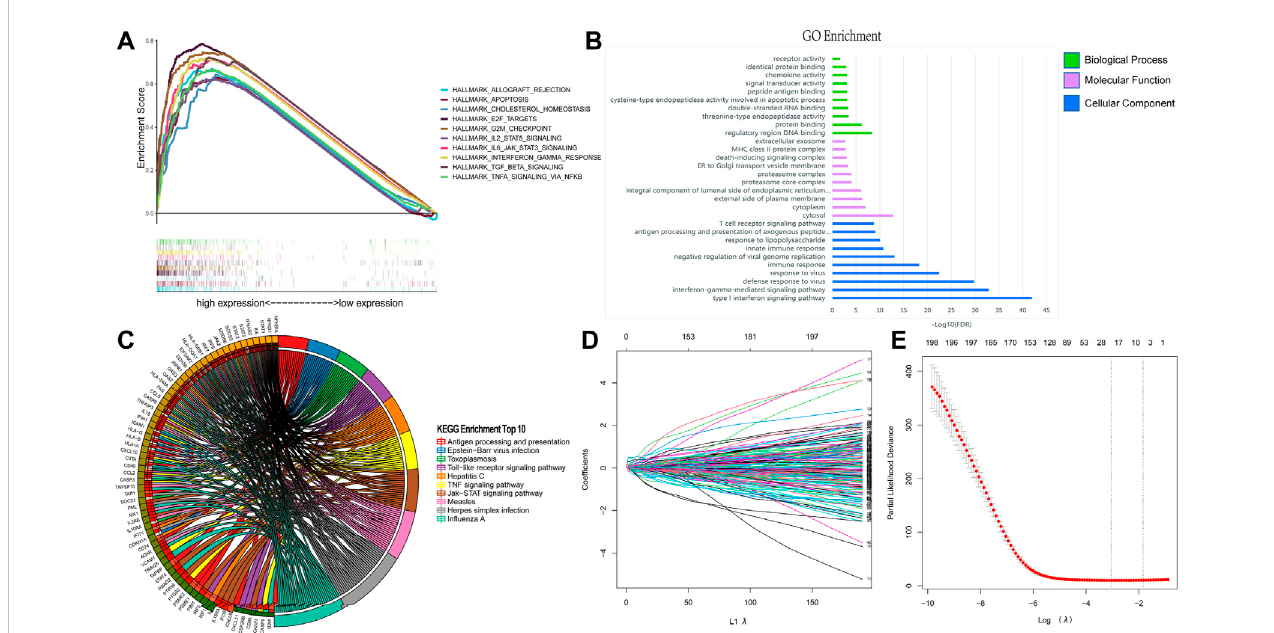
FIGURE 1 Identi fi cation of IFN- γ related genes. (A) GSEA analysis of glioma and normal samples from TCGA database. Enrichment analysis of 198 IFN- γ - related genes: (B) Enriched GO terms. (C) Kyoto Encyclopedia of Genes and Genomes Pathway. (D, E) Establishment and evaluation of risk scoring model based on IFN- γ -associated